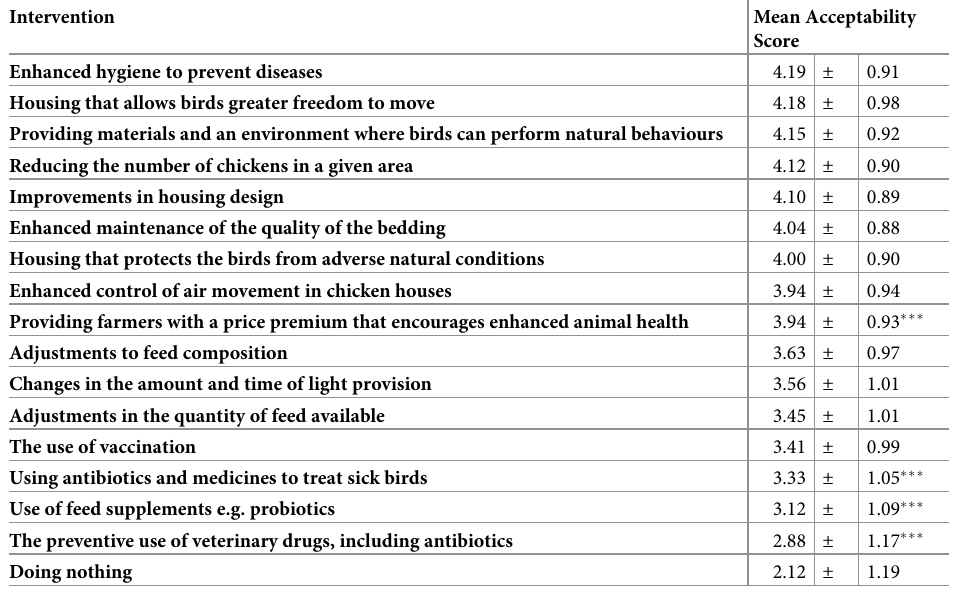
Table 5. Mean acceptability scores of interventions to control production diseases in broiler chickens (n = 789). Intervention